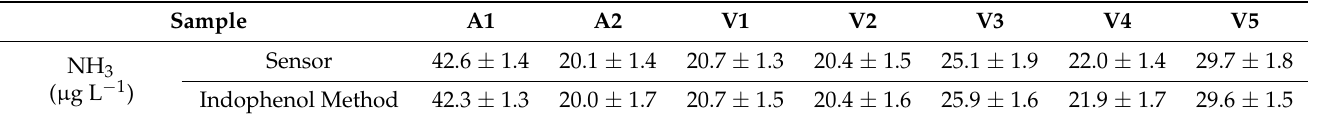
Table 2. Results obtained analysing samples using the acoustic sensor and the indophenol method.